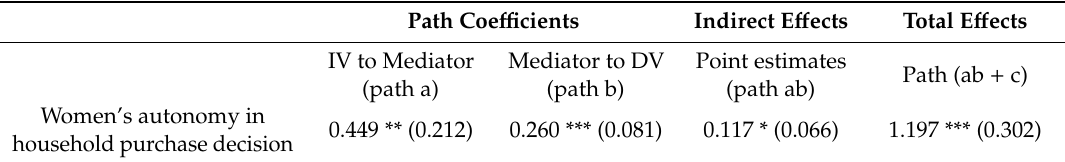
Table 5. Mediation effect of women’s land ownership on child growth stunting through women’s